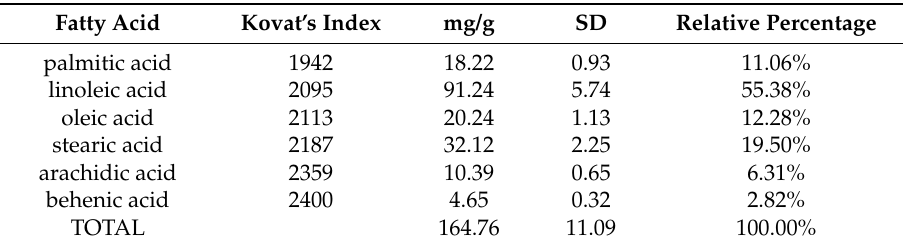
Table 2. Fatty acid composition of G. simplicifolia seeds.